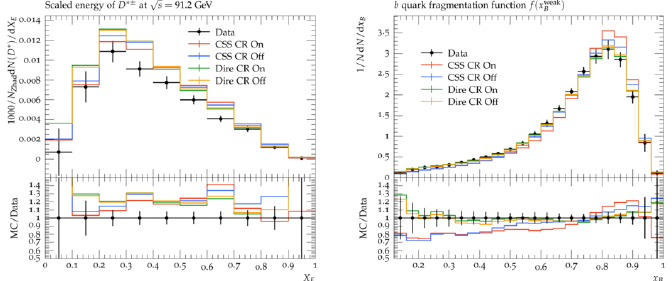
Figure 10: Fragmentation functions for D ∗± (left) and B mesons (right), from O PAL [ 67 ] and S LD [ 64 ]